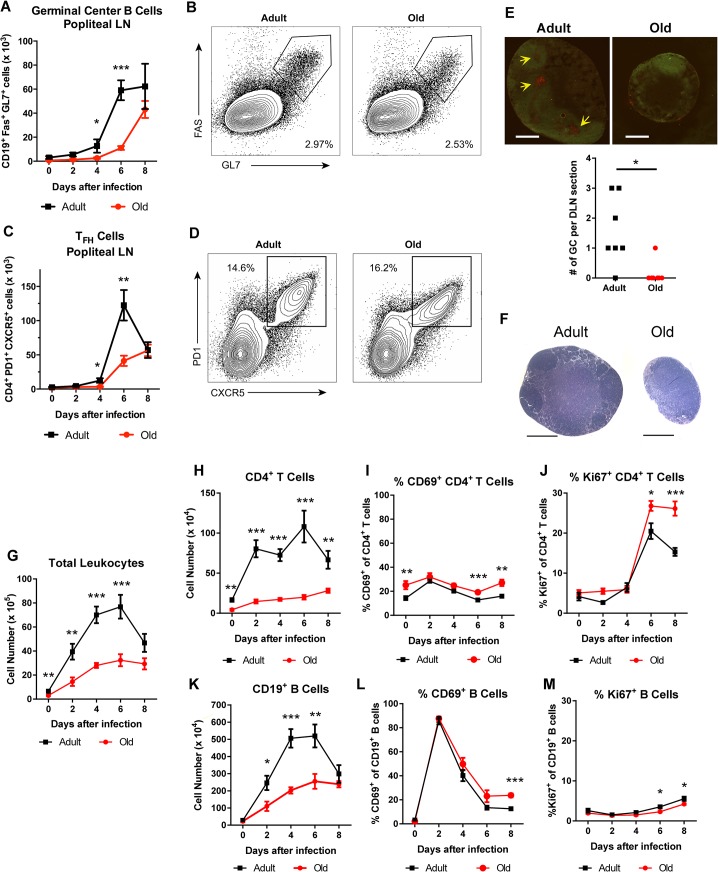
Delayed germinal center formation and decreased accumulation of CD4+ T cells and CD19+ B cells in DLN after WNV infection of old mice.Mice were infected with 102 PFU of WNV (New York strain) in the footpad. A-D. Draining popliteal LN cells were analyzed by flow cytometry at the indicated days after infection. Numbers of GC B cells (CD19+ Fas+ GL7+ cells) (A) and TFH cells (CD4+ PD1+ CXCR5+ cells) were quantified (C). B and D. Representative flow cytometry plots of GC B cells (B, on gated CD19+ cells) and TFH cells (D, on gated CD4+ cells) from adult and old mice at 8 days post infection. E. Immunofluorescence staining of germinal centers in DLN from 6 days post WNV-infected adult and old mice. Slides were stained with GL7-PE, and IgD-FITC. Arrows point to sites of active GCs indicated by GL7 staining in the red channel. In the graph, the number of GCs per section is recorded with each point representing a section taken from the center of draining popliteal lymph nodes from adult or old mice from two independent experiments. F. Hematoxylin and eosin stained sections of the draining popliteal LN from adult and old mice 4 days post infection. G-M. At the indicated days post infection, the DLN was harvested, and total cells were counted (G). Antibody staining detected specific lymphocyte subsets including CD4+ T cells (H) and CD19+ B cells (K). CD4+ T cells (I, J) and CD19+ B cells (L, M) were co-stained with antibodies to CD69 (I, L) or Ki-67 (J, M) to establish their state of activation or proliferation. The results are pooled from at least three independent experiments with a total of 6 to 14 mice per group. Data is expressed as the mean ± the standard error of the mean (SEM). Asterisks indicate statistical significance (*, P < 0.05; **, P < 0.01; ***, P < 0.001; Mann-Whitney test).